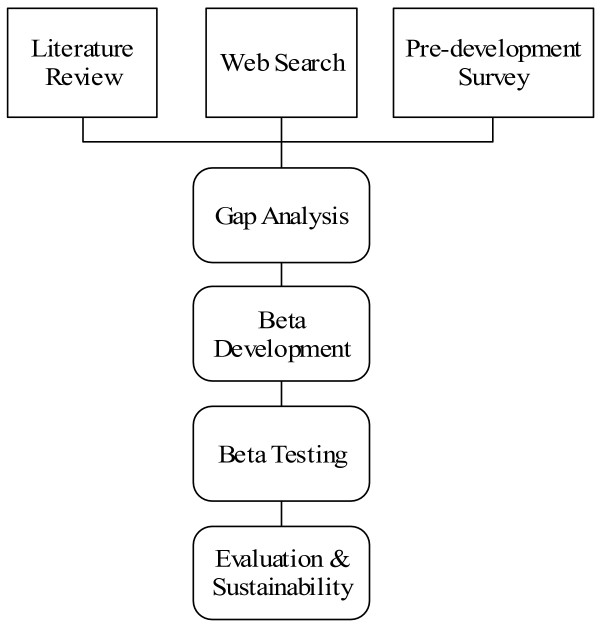
Main Project Stages.